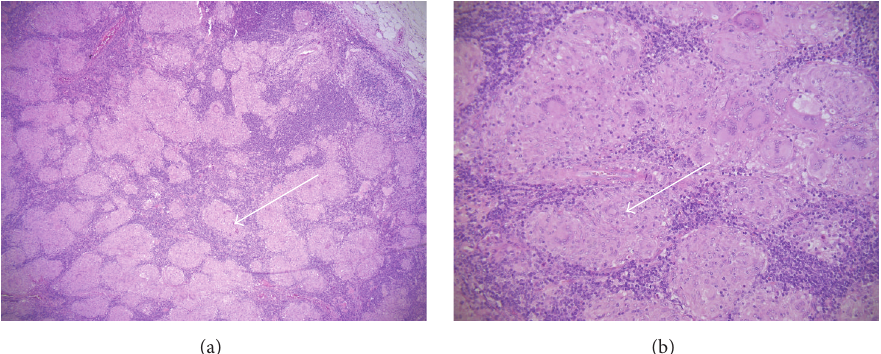
Figure 3: Axillary lymph node biopsy showing noncaseating granulomata (arrow) at × 50 magnification (a) and noncaseating granulomata (arrow) at × 200 magnification